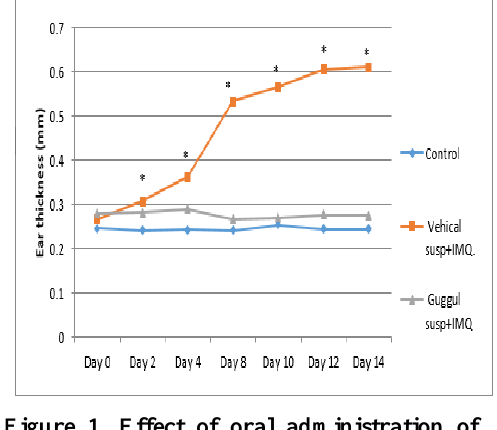
Figure 1. Effect of oral administration of guggulsterone on ear thickness in